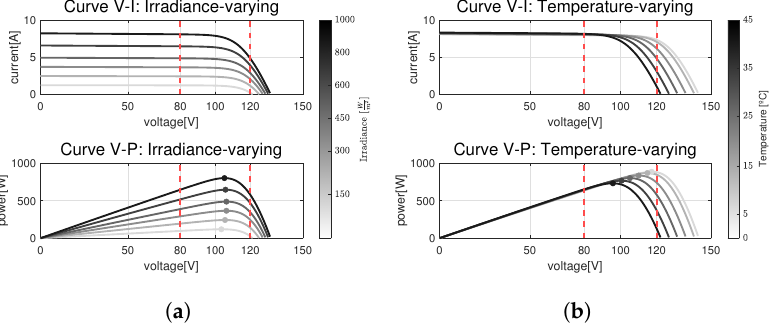
Curve V-P: Irradiance-varying